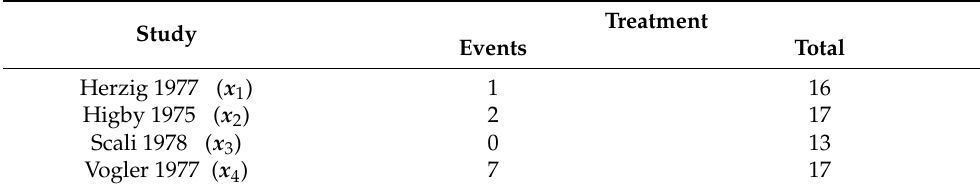
Table 2. Data in Stanworth et al. [19].